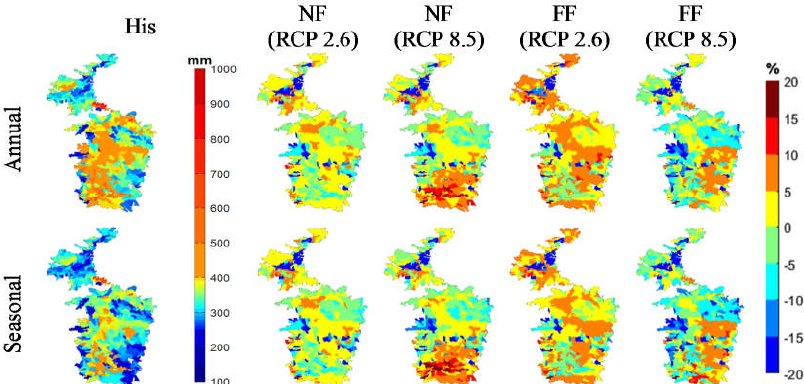
Figure 5. Spatial distribution of ET by RCP (representative concentration pathway) 2.6 and 8.5, where His indicates historical period (1983–2007), NF indicates near future (2010–2034) and FF indicates far future (2040–2064). For historical period simulated ET is shown in the map, and for the NF and FF percentage change is shown in the map. Water 2018 , 10 , x FOR PEER REVIEW